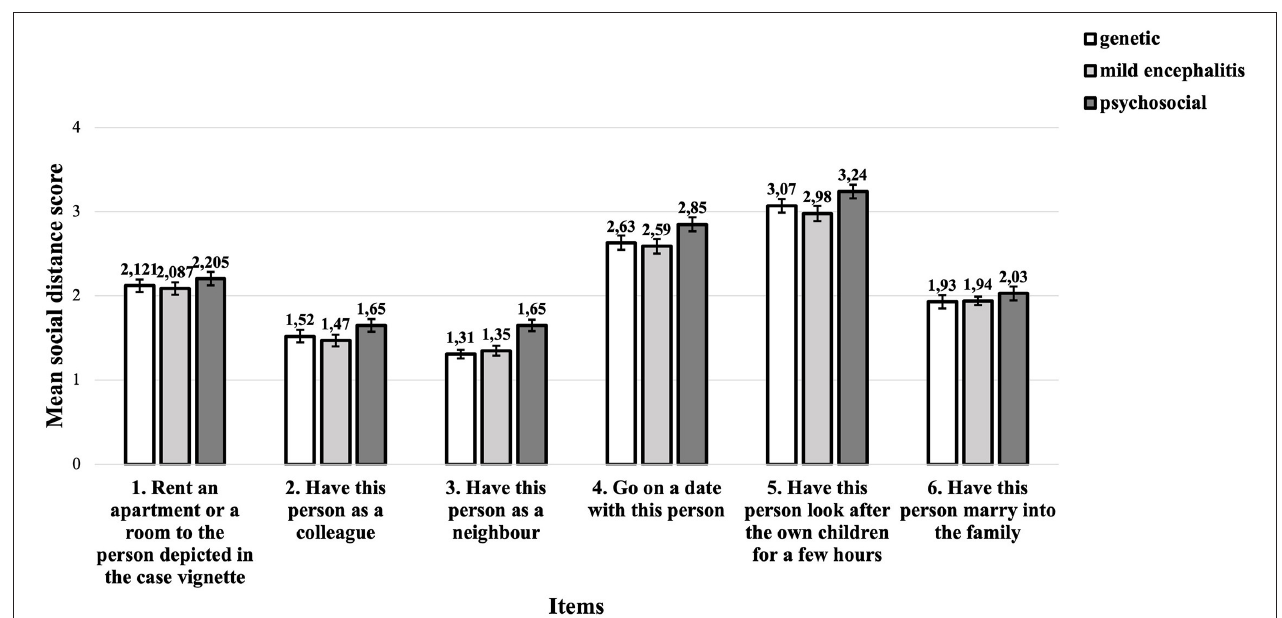
FIGURE 4 | Mean social distance score as a function of items and given causal explanation.